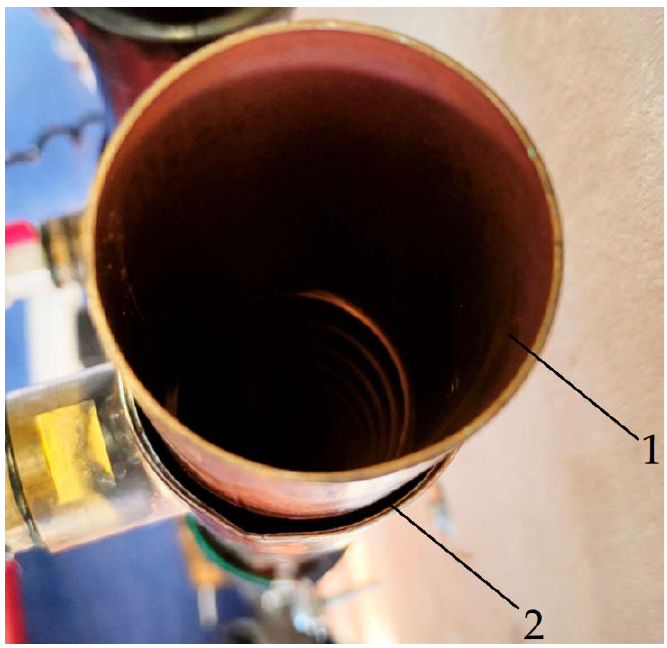
Figure 7. Typical cross section of a vertical heat exchanger; 1 — grey water drain, 2 — cold water